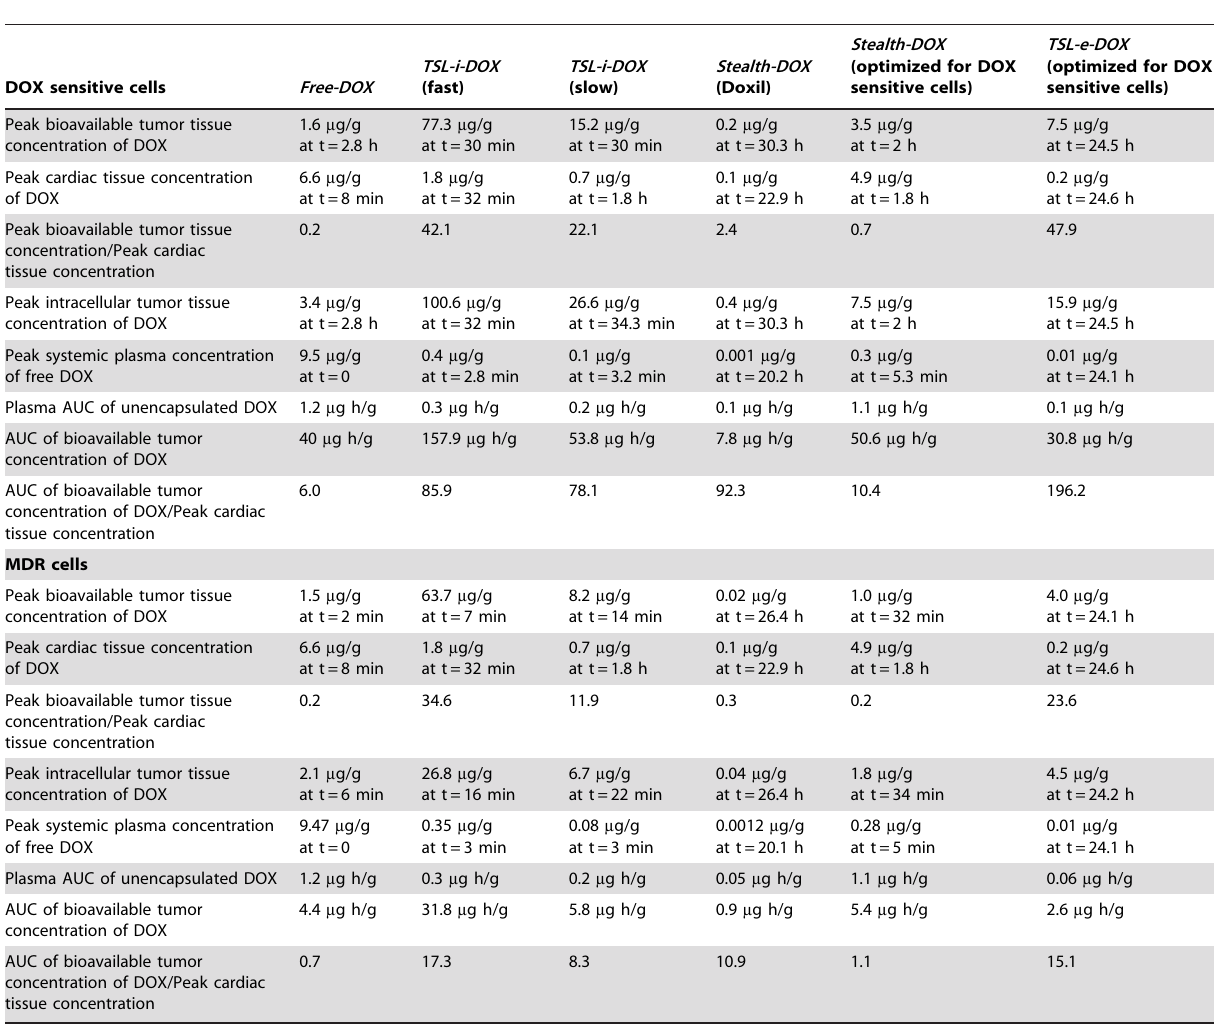
Table 2. Comparison between different DOX formulations for both DOX sensitive cells and MDR cells.